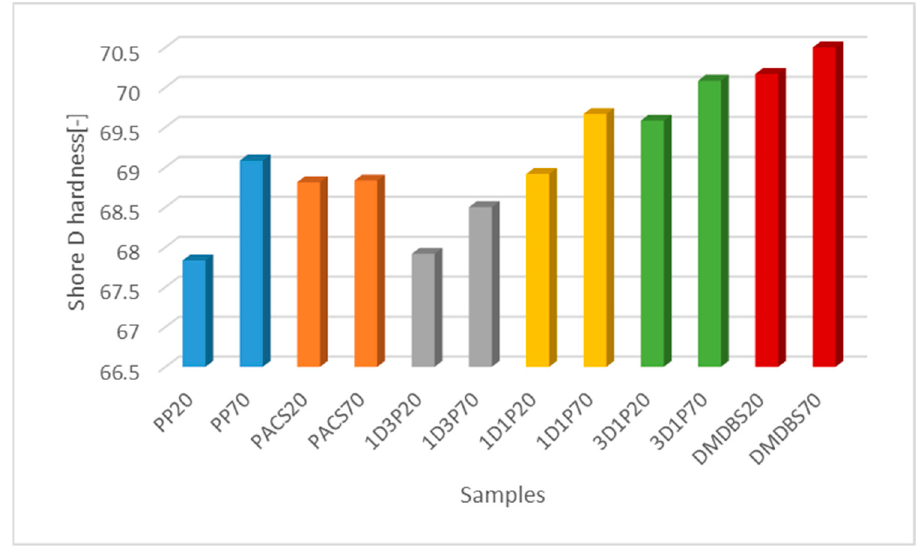
Figure 3. The Shore D hardness of the PP samples with various NA’s composition produced by mold temperature of 20 °C and 70 °C.